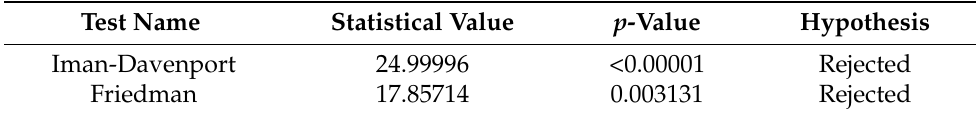
Table 7. Statistical results based on mean of objective values for UCI datasets.